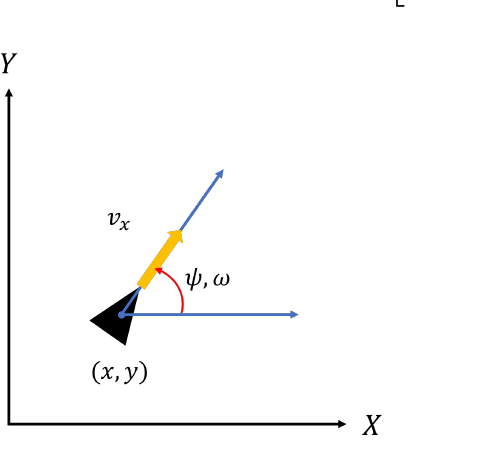
Figure 6. Unicycle model.